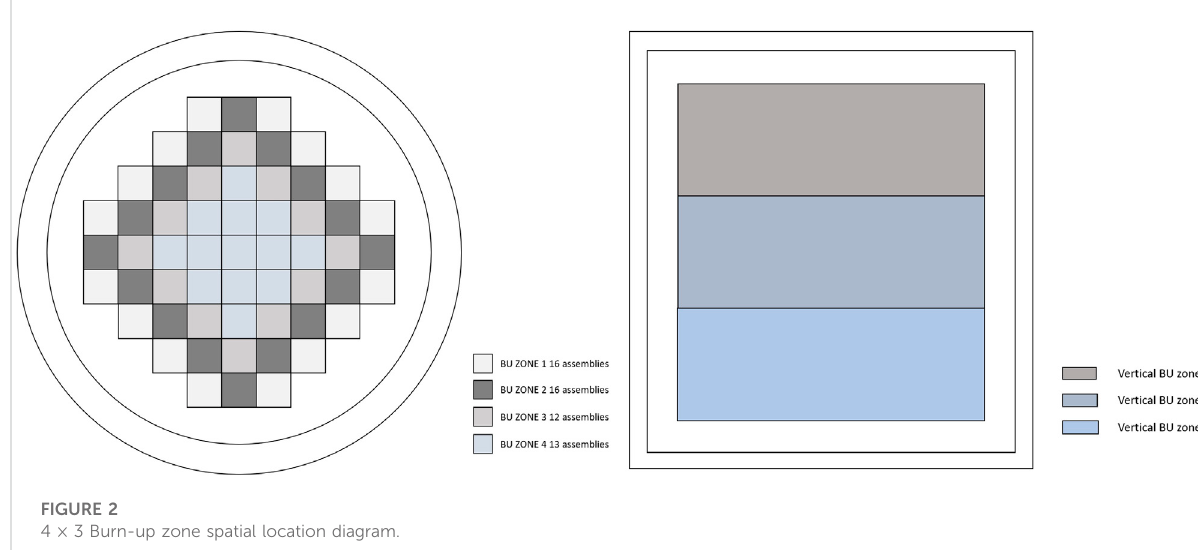
FIGURE 2 4 × 3 Burn-up zone spatial location diagram.